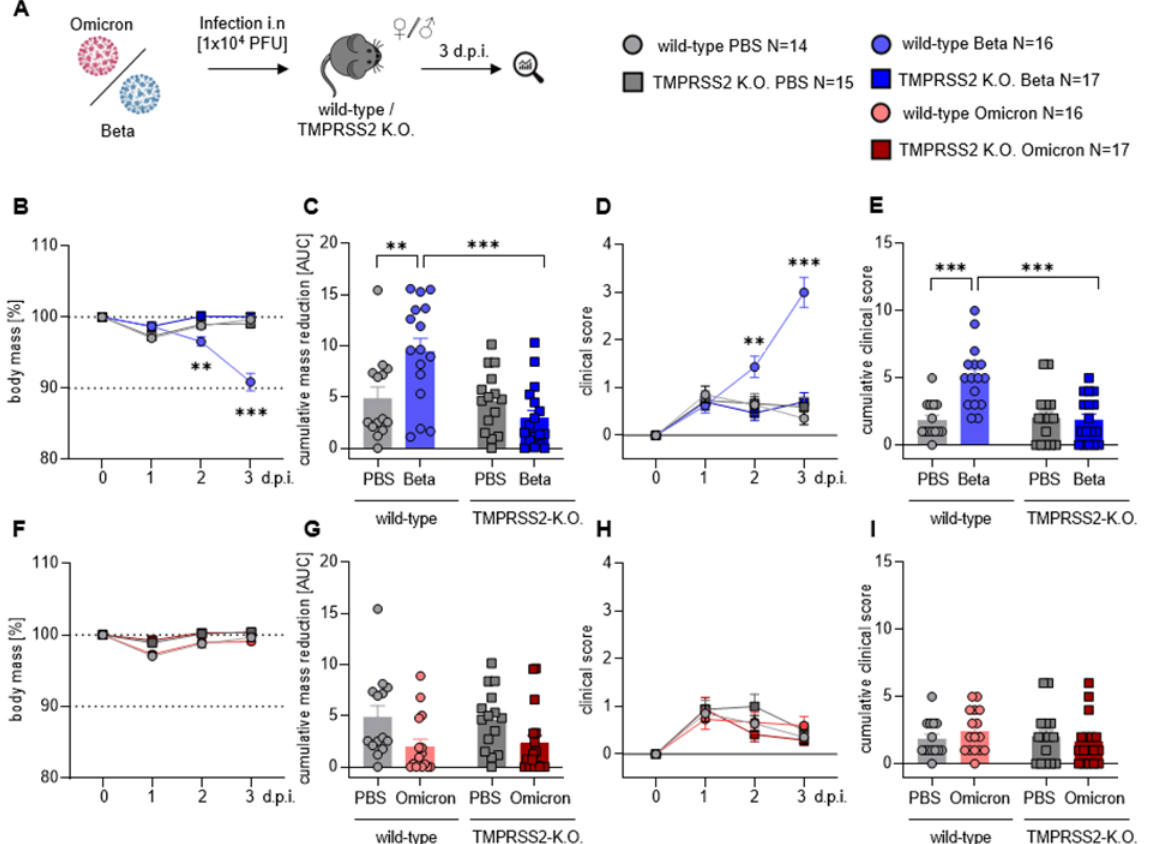
Figure 1. TMPRSS2 is essential for pathogenesis upon infection with the SARS-CoV-2 Beta variant. ( A ) Wt and TMPRSS2 KO mice were i.n. infected with 10 4 PFU of SARS-CoV-2 Beta or Omicron. Uninfected control mice were i.n. treated with PBS. Body mass and clinical scores were monitored until 3 dpi ( B , F ) Relative body mass of SARS-CoV-2 Beta ( B ) or Omicron ( F ) infected mice. ( C , G ) Cumulative relative mass reduction in SARS-CoV-2 Beta ( C ) or Omicron ( G ) infected mice until 3 dpi are shown as area under the curve (AUC). Data for individual mice are shown as symbols. ( D , H ) Clinical scores of SARS-CoV-2 Beta ( D ) or Omicron ( H )-infected mice. ( E , I ) Cumulative clinical score in SARS-CoV-2 Beta ( E ) or Omicron ( I ) infected mice until 3 dpi. Data for individual mice are shown as symbols. ( B – I ) Data are plotted as means and error bars denote SEM. Statistical significance for sequential body mass and clinical scores ( A , D , F , H ) was calculated using two-way ANOVA with Geisser–Greenhouse correction, and the correction for multiple comparisons was calculated following Tukey. Statistical significance for cumulative data sets ( C , E , G , I ) was calculated with Welch’s t test (two-tailed) (** p < 0.01, *** p < 0.001).